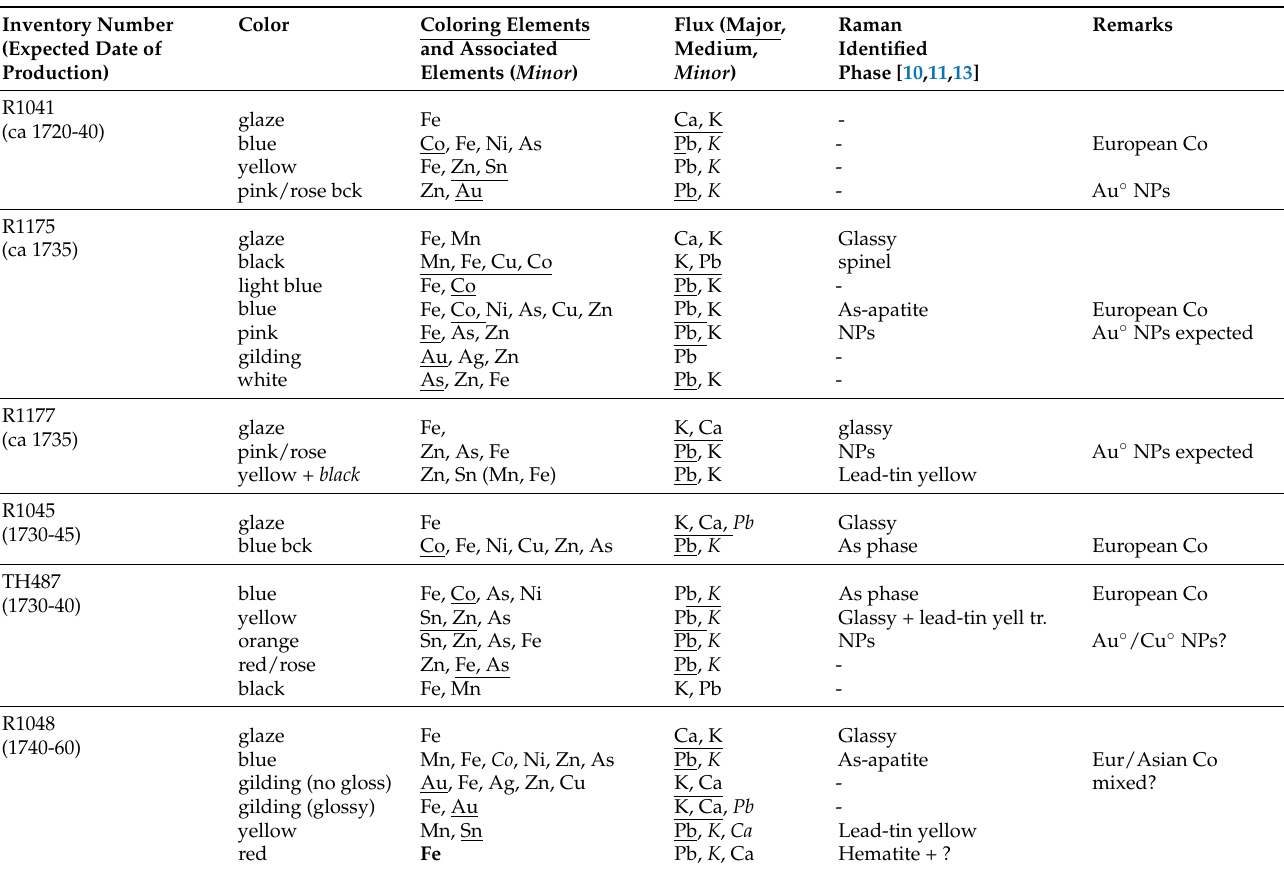
Table 2. Comparison between main coloring elements and associated ones, fluxing elements and phases identified by Raman microspectroscopy (The characteristics of the terms underlined or put in italic in the table are explained for each